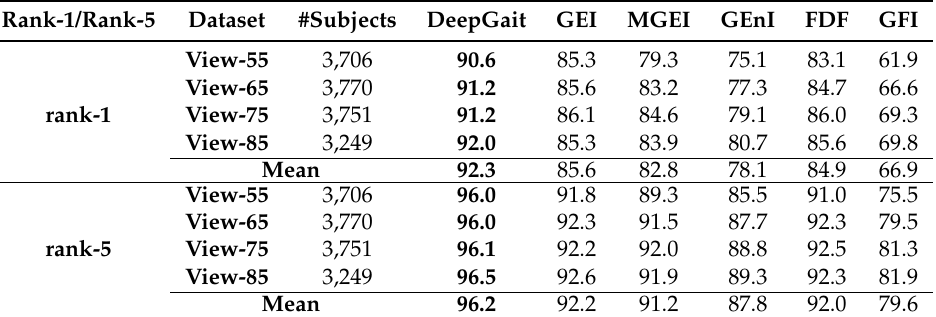
Table 1. Comparison of rank-1 (%) and rank-5 (%) identification rates with different gait representations on the whole dataset (NN). GEI: Gait Energy Image; MGEI: Masked GEI based on GEnI; GEnI: Gait Entropy Image; FDF: Frequency-Domain Feature; GFI: Gait Flow